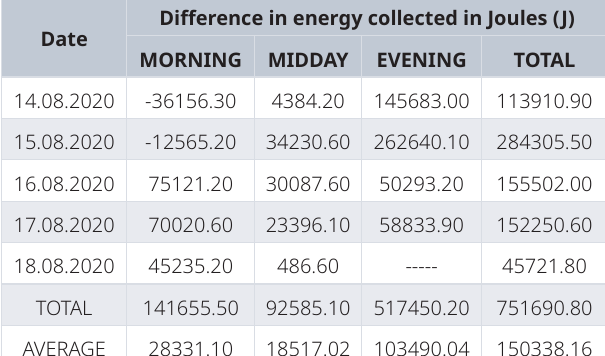
Table 3. Difference in energy collected between stationary and solar tracking panels.